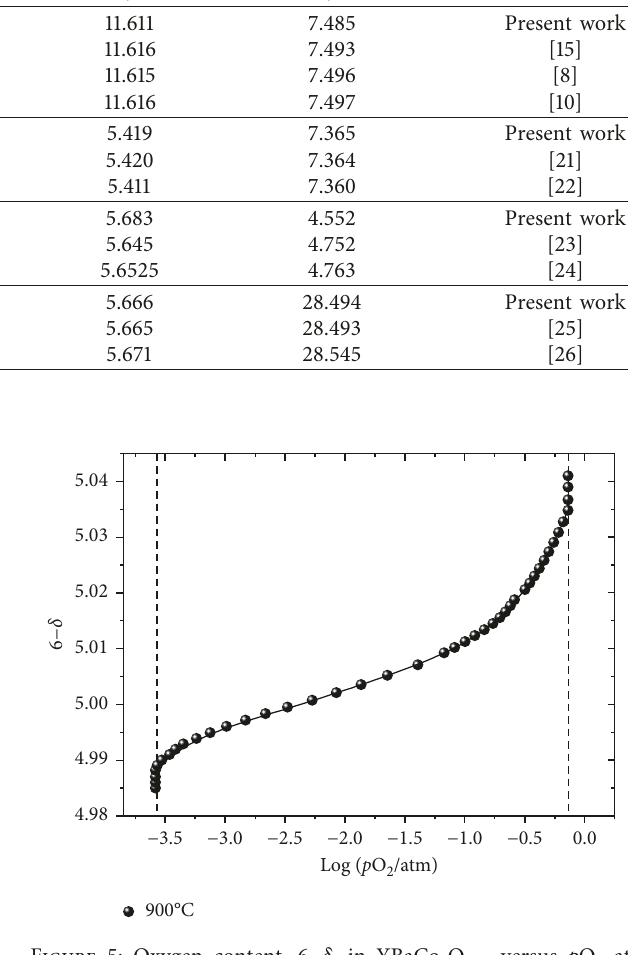
Table 1: Refined cell parameters and space groups of the as-prepared oxide compounds. Compound Space group